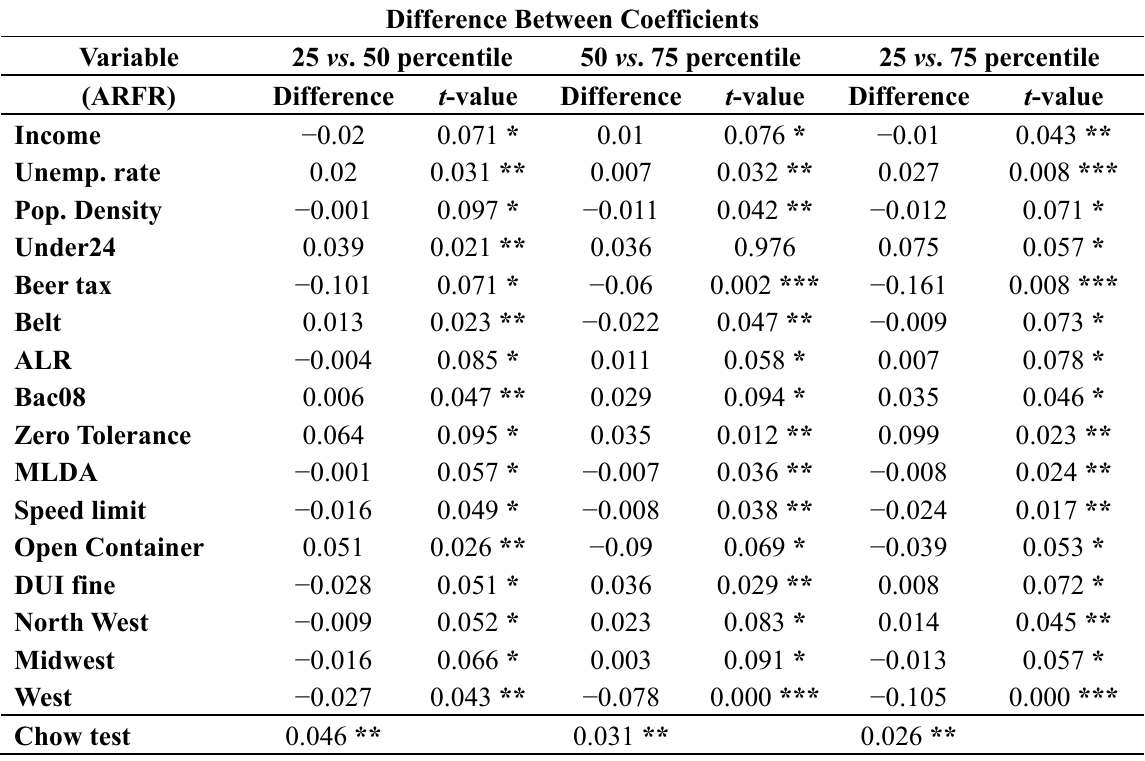
Table 3. Comparison between coefficients from different quantile